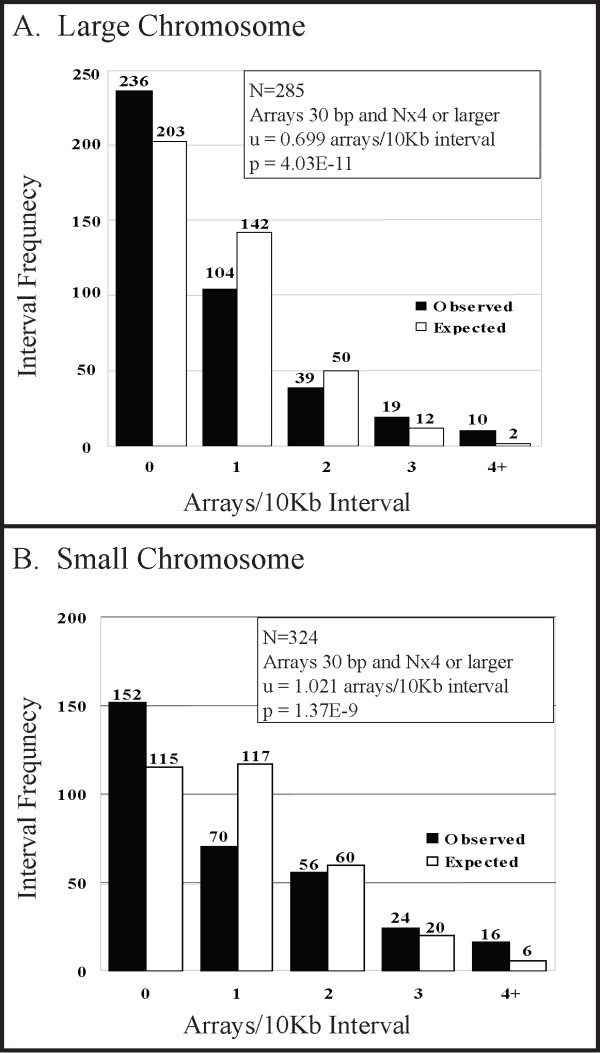
Repeat array distribution Goodness-of-fit test against a Poisson distribution. The bar graphs in each of the panels indicate the observed and expected number of 10 Kbp intervals containing zero, one, two, three and four or more repeat arrays for the B. pseudomallei large (A) and small (B) chromosomes. For each chromosome, the total number of arrays, average arrays/interval used to generate the Poisson expected frequencies, and calculated p values are shown. Values above each bar indicate the observed or expected frequencies in each category.